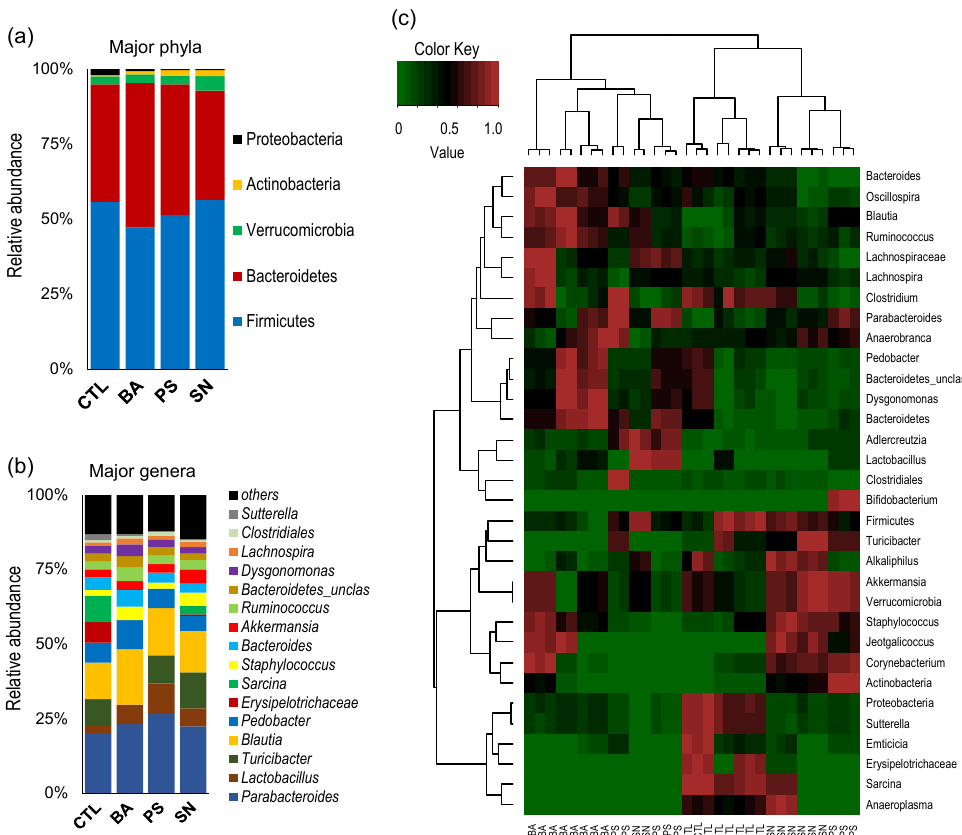
Figure 2. Distinct gut microbiota composition in mice fed with different preservatives. The microbiota composition at the level of major phyla ( a ) and genera ( b ), and the hierarchical clustering heatmap ( c ) depicting distinct spectrums of gut microbiota in mice consuming benzoate (BA), potassium sorbate (PS), or sodium nitrite (SN) versus control (CTL) mice.